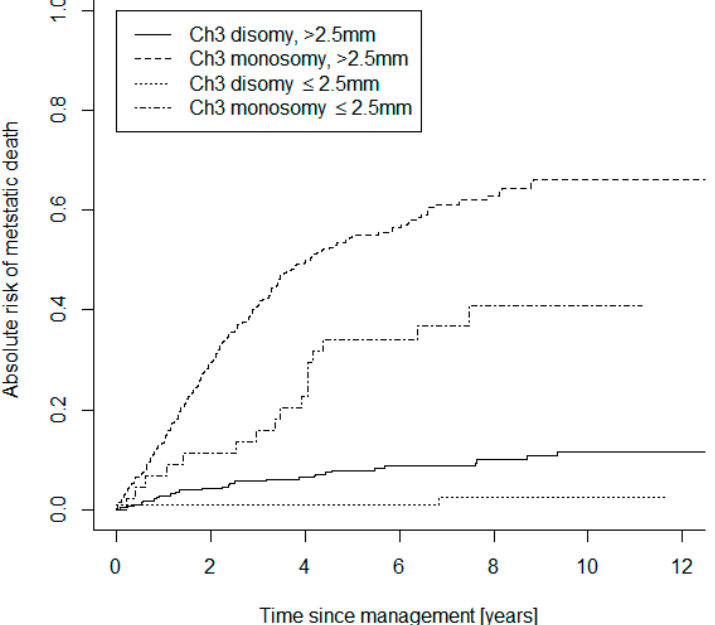
Figure 1. Curves showing the comparative absolute risks of mortality due to metastatic UM in monosomy 3 and disomy 3 tumors subdivided into the defined ‘small’ and ‘large’ categories. In particular, the 5-year absolute risk of mortality of small M3-UM was 23% versus larger M3-UM at 50% (small D3-UM 0.8%; large D3-UM 6.4%). Log-rank analysis also demonstrated a significant difference in the hazard rates of small M3 versus large M3 UM ( p = 0.003), between small D3 and large D3 UM ( p = 0.007) and between each of the remaining subgroup comparisons ( p <